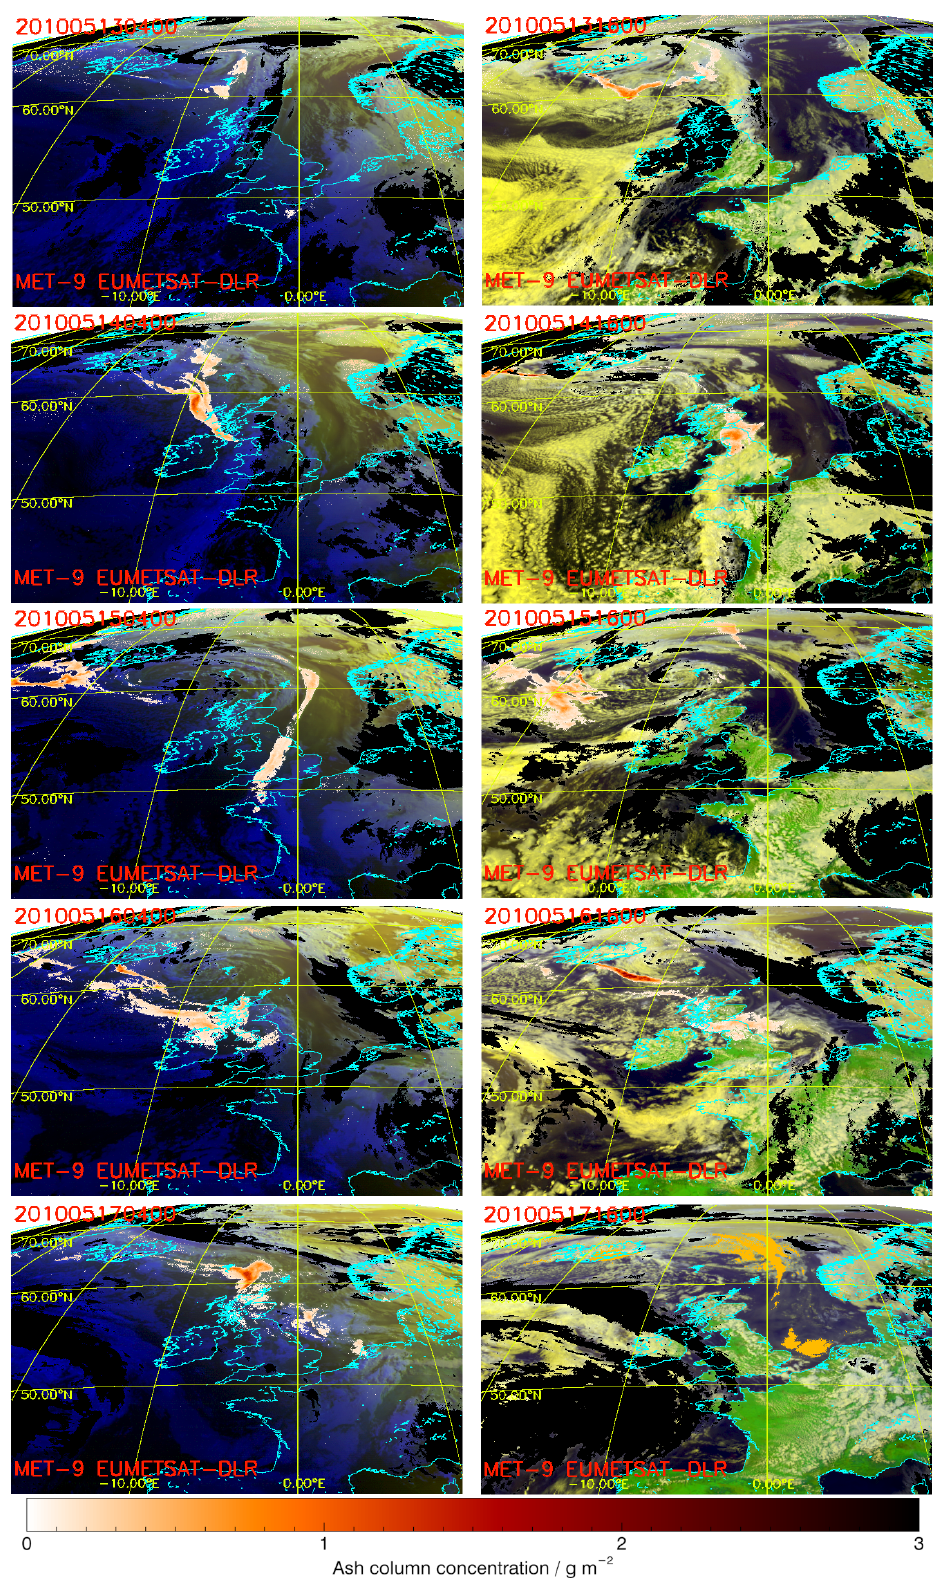
Figure 3. False colour RGB images with VAMC as white–red cloud on top (0–3gm − 2 ) for the Eyjafjallajökull eruption in May 2010. Here, SEVIRI2 observations are shown between 13 May 2010 04:00UTC and 17 May 2010 16:00UTC in 12h steps.